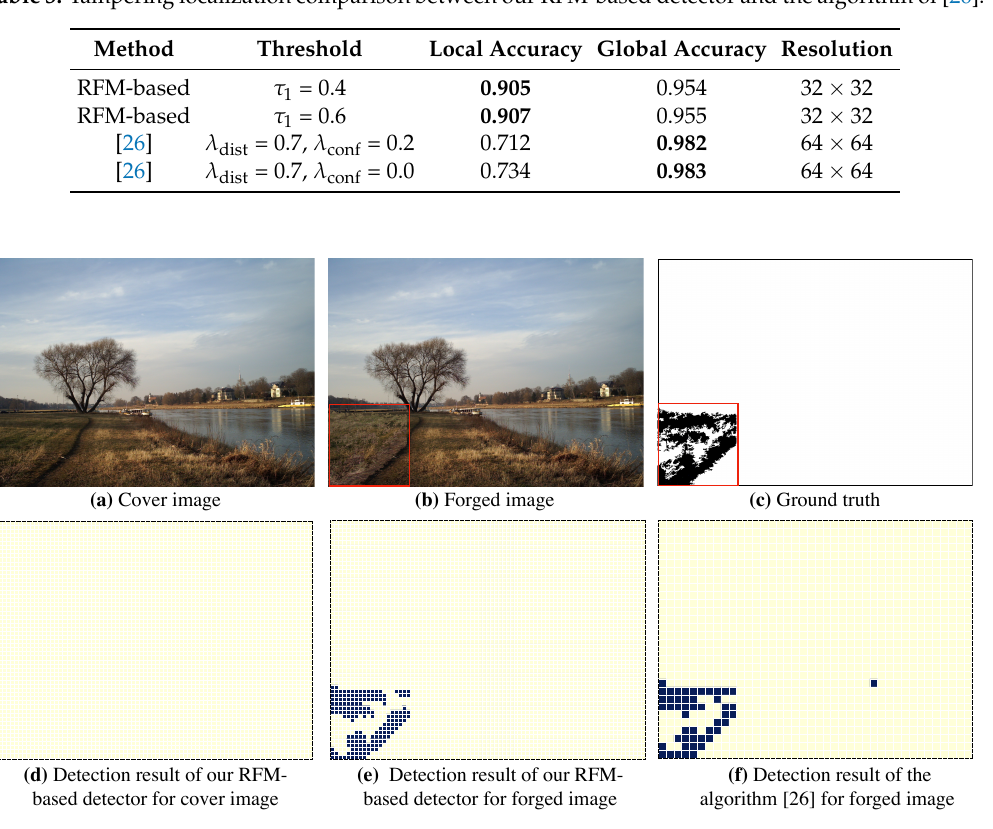
Figure 9. Comparison of localization performance between our RFM-based detector and the algorithm of